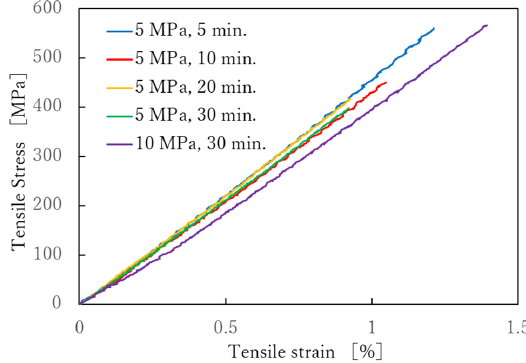
Figure 7. Stress-strain curves of the tensile test.